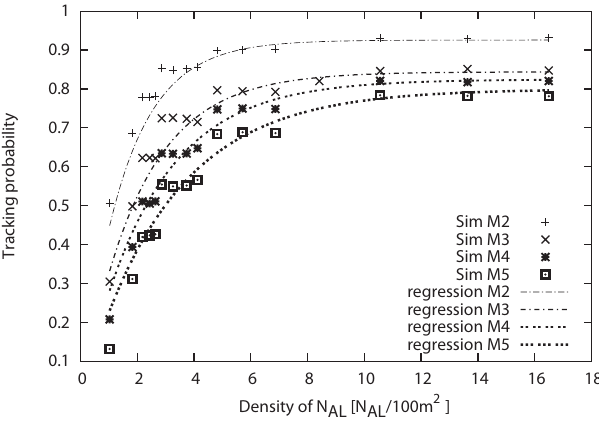
Figure 13. Comparison between simulations and approximate formula representing the re- lationship between sensor density and tracking probability.